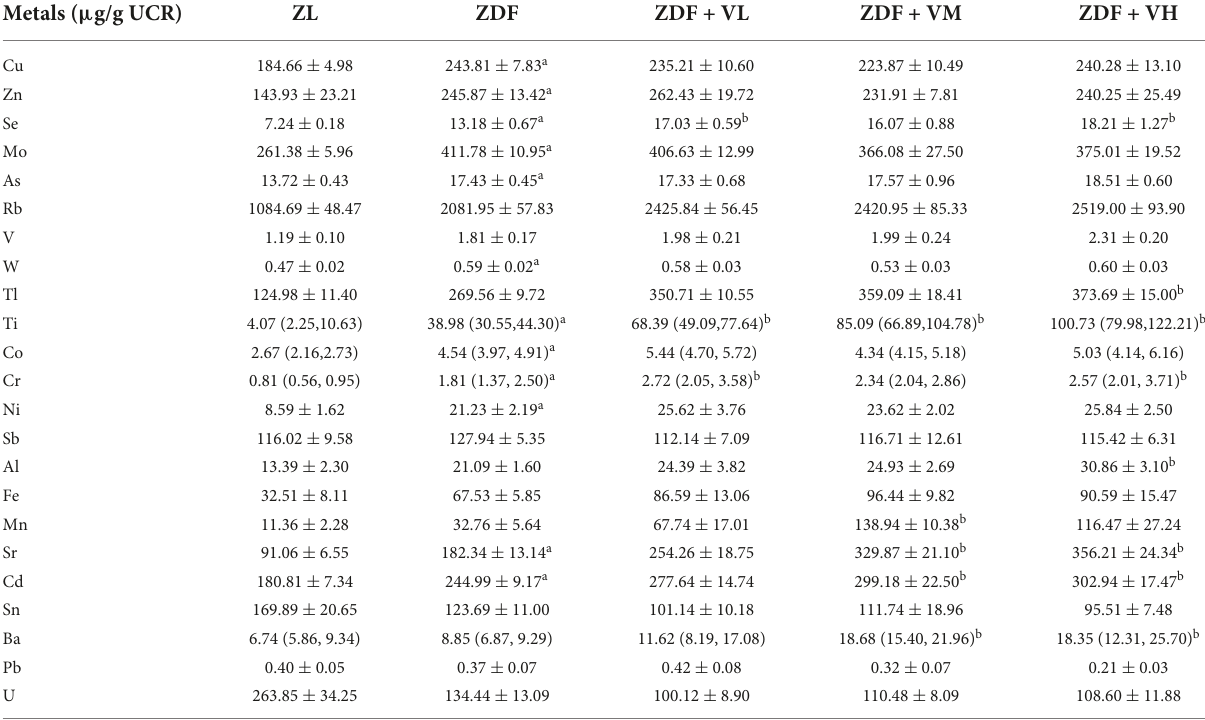
TABLE 2 Effects of 1,25(OH) 2 D 3 on urine metal concentration of Zucker rats in the first week of treatment. Metals ( µ g/g